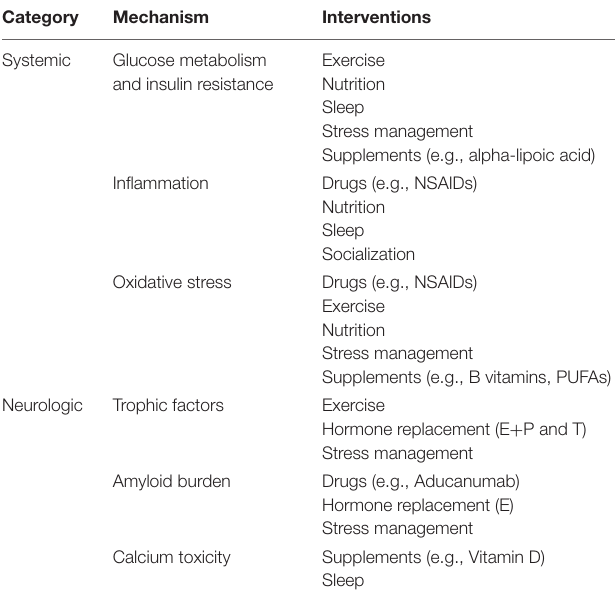
TABLE 1 | Interventions for systemic and neurologic mechanisms in Alzheimer’s